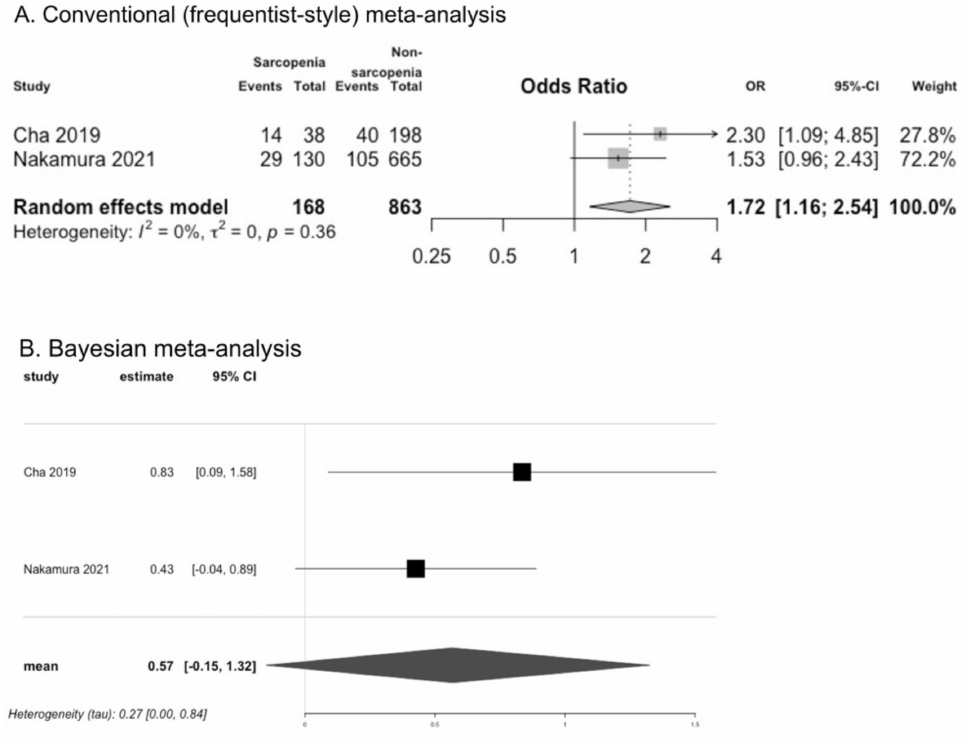
Figure 5. Comparison of presence of dysphagia between individuals with and without sarcopenia